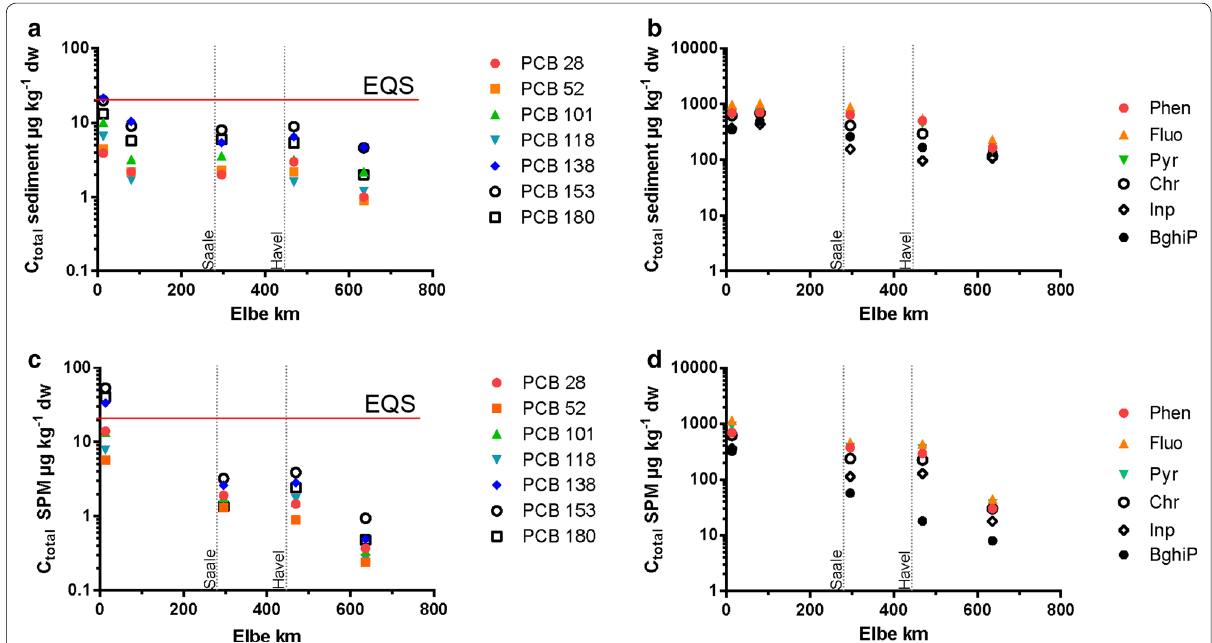
Fig. 2 C total (µg kg − 1 dry weight) of PCBs ( a , c ) and selected PAHs ( b , d ) in sediment and SPM along the German part of the River Elbe. The red line marks the environmental quality standard (EQS) of 20 µg kg − 1 for single PCBs in sediment and SPM (German Surface Water Regulation). Data points